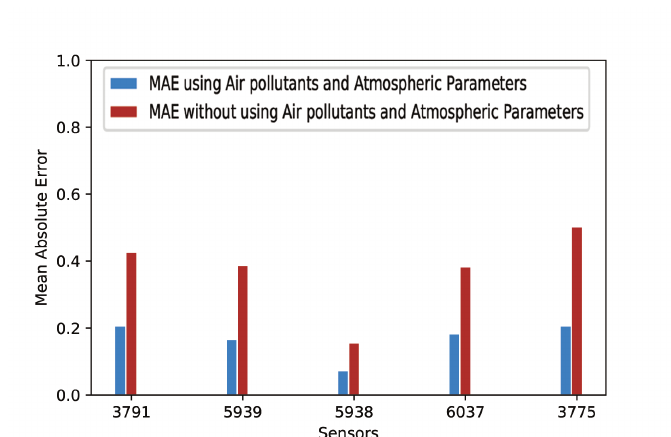
Figure 11. MAE with and without using air pollutants and atmospheric parameters.